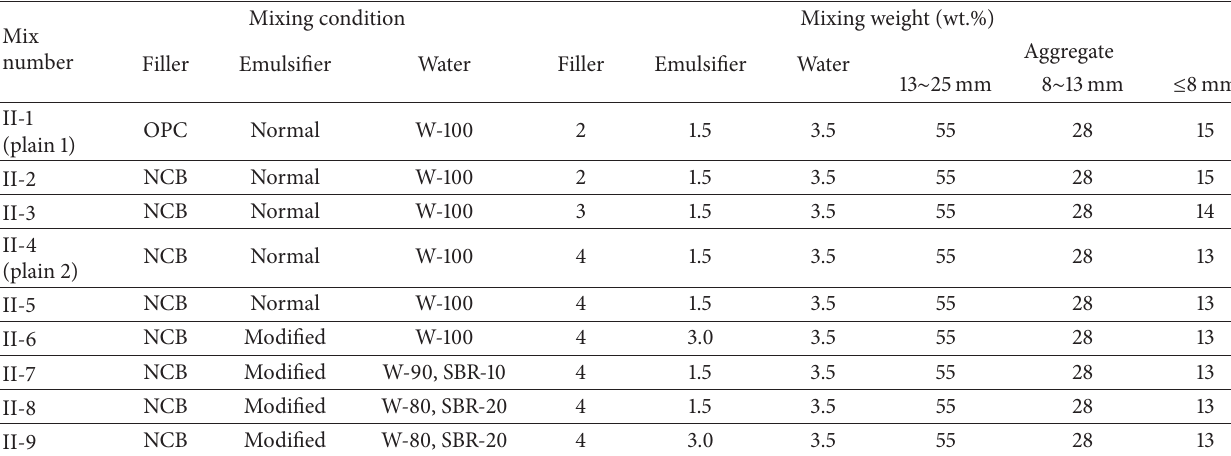
Table 7: Recycled cold asphalt mixing ratio